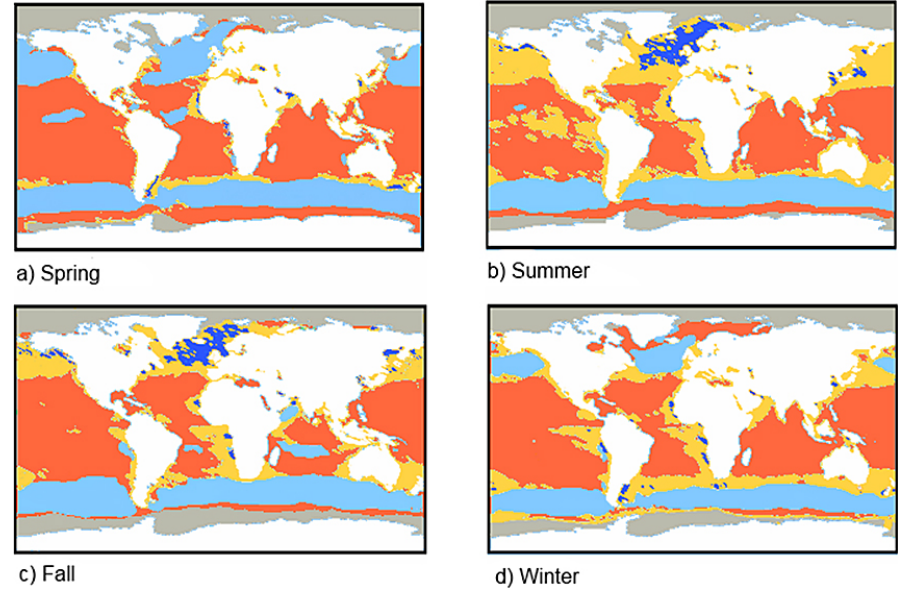
Fig. 8. Global maps of mean concentrations of surfactants in the SML ( ± 95% confidence interval of mean) and their enrichment factors (EF) for (a) April–June, (b) July–September, (c) October–December and (d) January–March. Red: 320 ± 66µgTeqL − 1 , EF > 2; yellow: 502 ± 107µgTeqL − 1 , 2 > EF > 1.5; dark blue: 663 ± 77µgTeqL − 1 , 1.5 > EF > 1.0; light blue: no